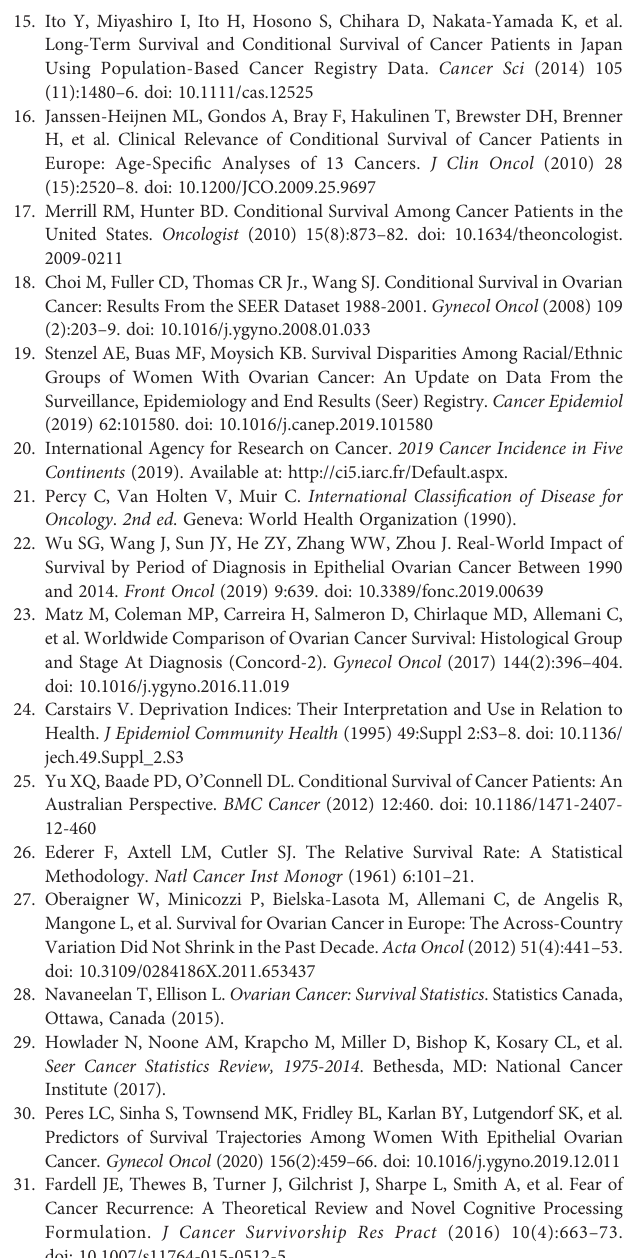
Supplementary Figure 1 | Histology and stage distribution of ovarian cancer patients (A) histology distribution by age group (B) stage distribution by histologic